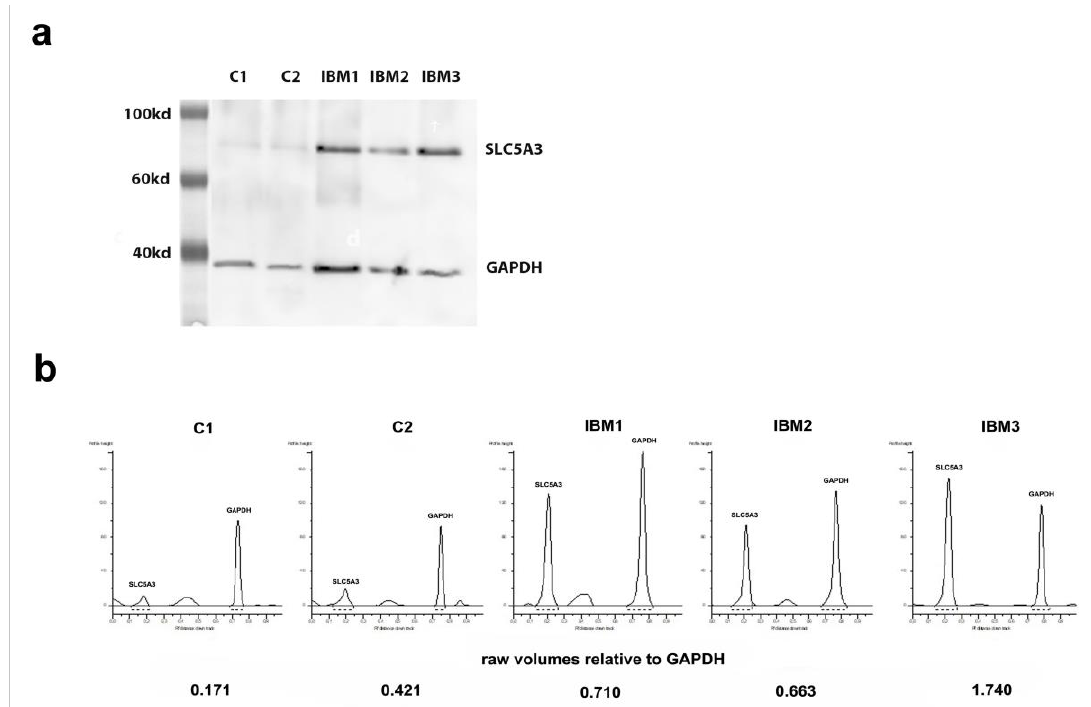
Figure 3. ( a ) Western blot visualizations of SLC5A3 with the Ab3 antibody, detected simultaneously with anti-glyceraldehyde-3-phosphate dehydrogenase (GAPDH), the latter as a control for differences in protein densities of samples. Note a very faint SLC5A3 protein band in controls (C) and prominent bands in muscle samples from patients with sporadic inclusion body myositis (IBM). ( b ) Raw volumes of protein bands as quantified using GeneTools software, with SLC5A3 density calculated relative to the GAPDH level of the sample.